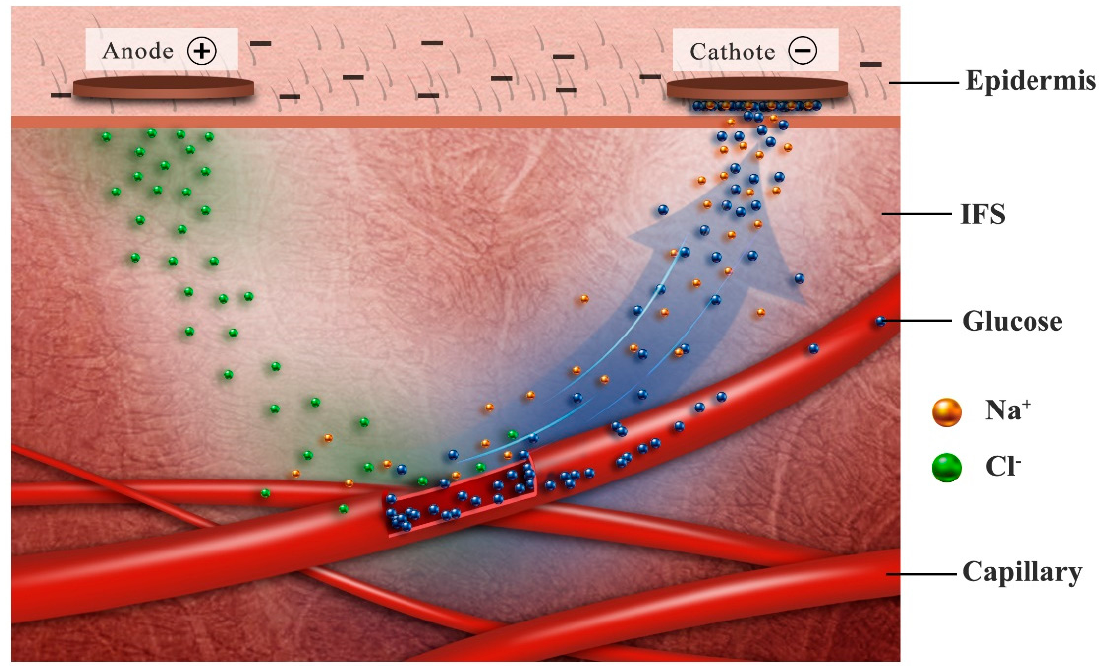
Figure 8. Schematic diagram of reverse iontophoresis (RI).